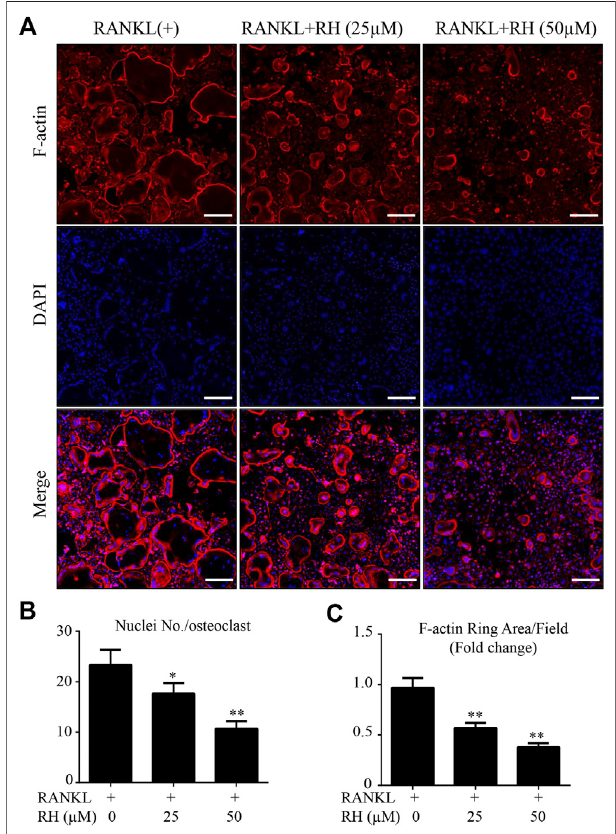
FIGURE 2 | RH inhibited the formation of F-actin belt during the osteoclast formation induced by RANKL. (A) The confocal images of F-actin ring formation were detected with Rhodamine Phalloidin, combined DAPI staining for nuclei respectively. Scale bar, 200 μ m. (B) Quanti fi cation of the nucleus number per osteoclast under the different concentrations of RH. (C) Quanti fi cation of the average of actin ring area per fi eld ( n (cid:2) 3). * p < 0.05, ** p < 0.01 relative to RANKL-induced control group. Scale bar (cid:2) 200 μ